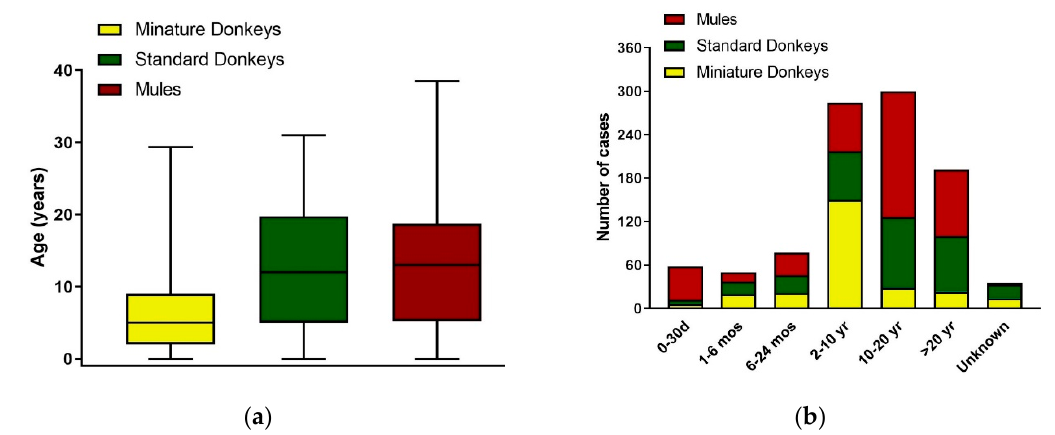
Figure 4. Age Distribution of Donkey and Mule Cases from 2008 to 2017. ( a ) Age distribution by median, interquartile and range; ( b ) Age distribution by categories: 0 to 30 days, greater than 1 month to 6 months, greater than 6 months to 24 months, greater than 2 years to 10 years, greater than 10 years to 20 years, and greater than 20 years; d = days; mos = months; yr = years. Standard donkeys (green), miniature donkeys (yellow), and mules (red).